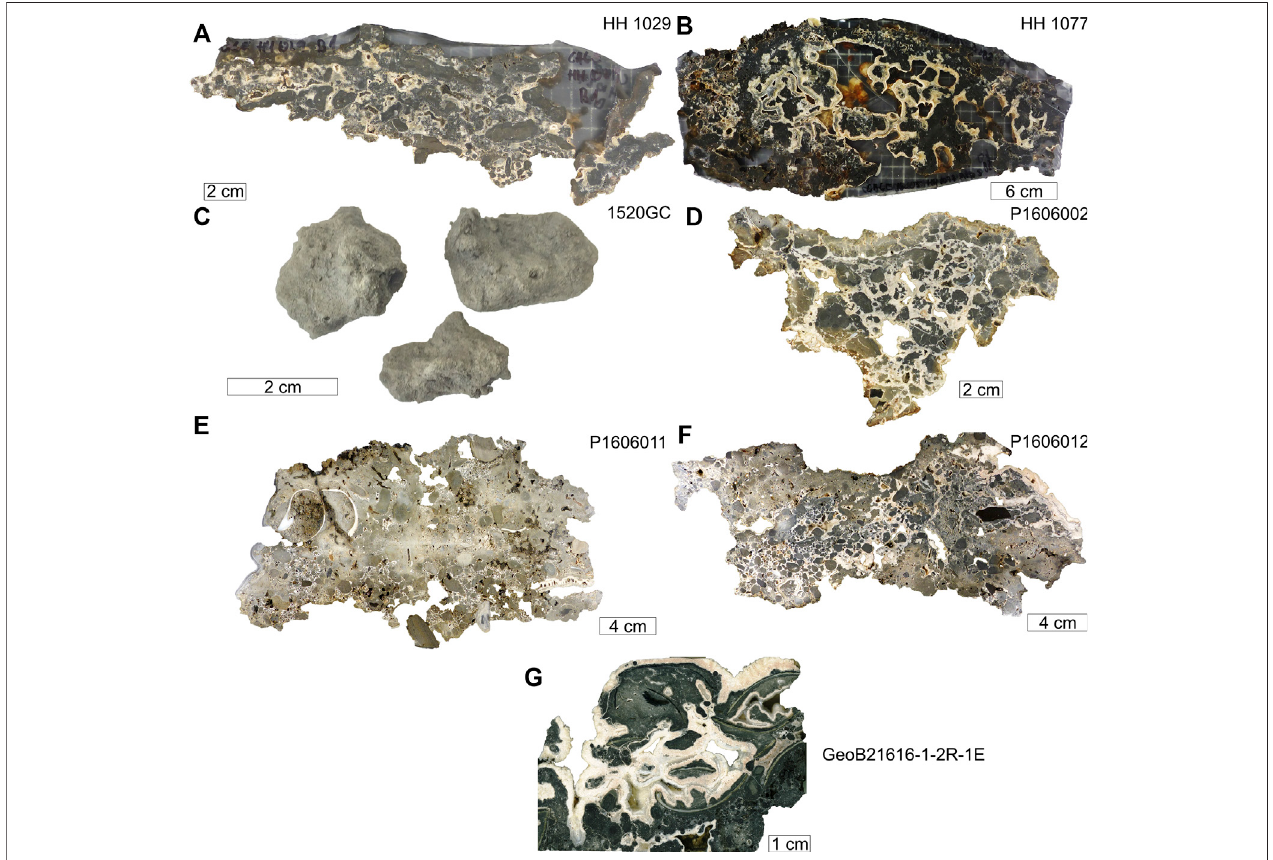
FIGURE 2 | Macroscopic photographs of the investigated seep carbonates [ (A – C) : Storfjordrenna gas hydrate mound; (D – G) : Vestnesa Ridge)]; samples (A,B,D – G) are epoxy-impregnated cut slabs. (A,B,D – G) Porous intraformational breccias composed of rounded, dark gray microcrystalline aragonite cemented sediment clasts cemented by mm-to cm-thick whitish void- fi lling aragonite (adapted from Himmler et al., 2019). (C) Light gray microcrystalline Mg-calcite cemented sediment nodules. (E – G) with sporadic pebble-sized glaciogenic debris and bioclasts (gastropod and bivalve shell fragments).